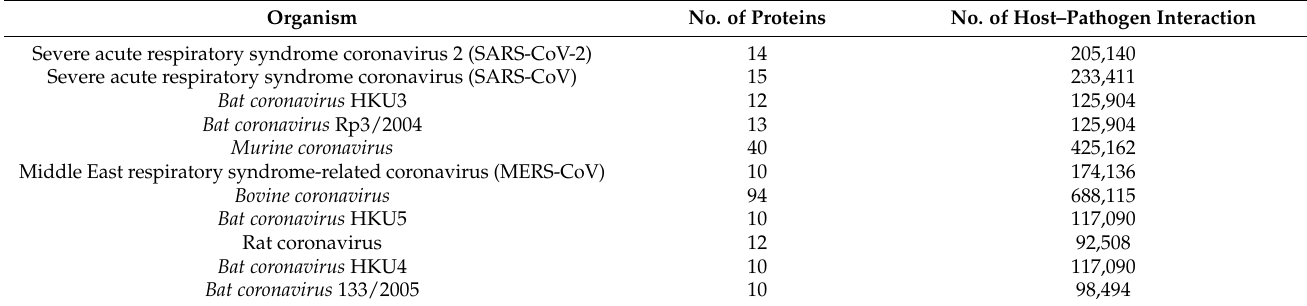
Table 1. Detailed description of proteins and host–pathogen interaction for all organisms from the coronavirus family.